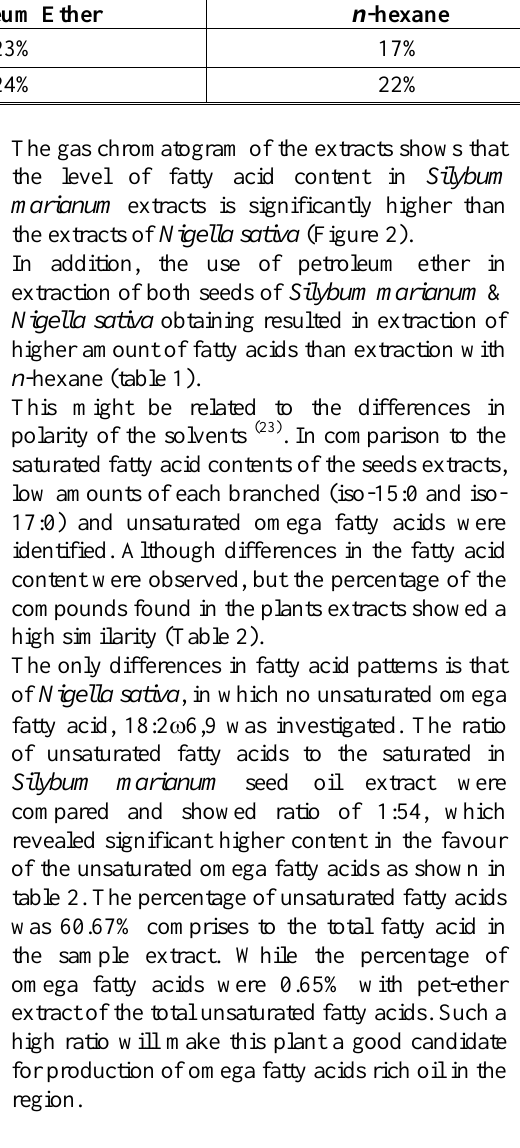
Figure 1: Diagram showing the relative amount of the fatty acid compound found in extracts of the Silybum marianum and Nigella sativa seeds using petroleum ether. The data was estimated by measuring the peak area of the GC